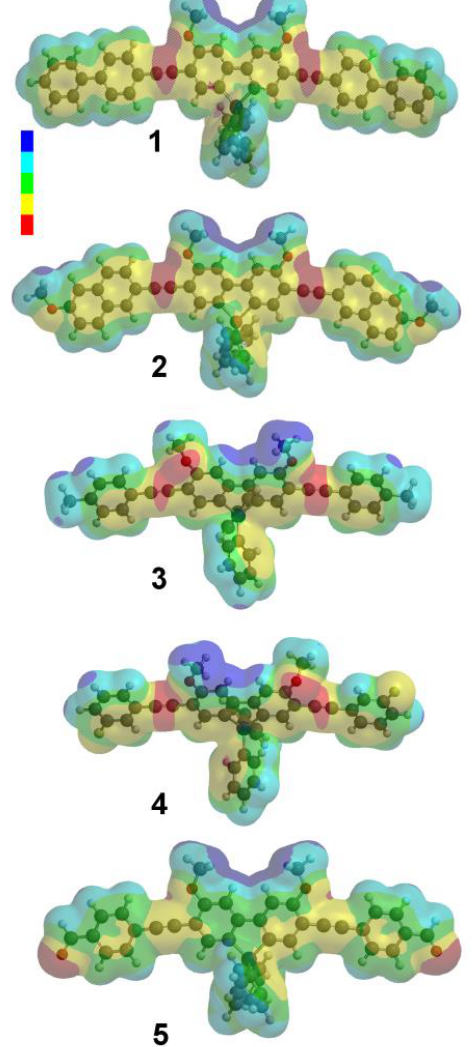
Figure 2. Electrostatic potential maps of 1 – 5 . Conditions: Ground State, B3LYP-6-31G* in simulated dimethyl formamide (DMF)